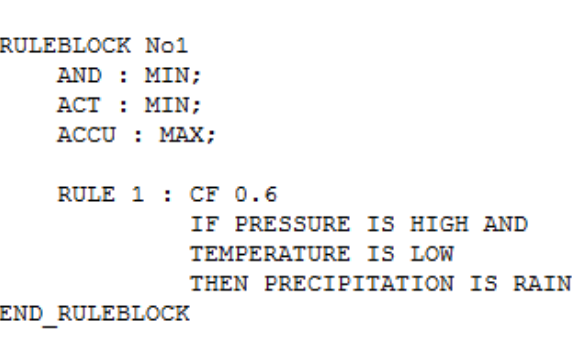
Figure 7. An example of an uncertain fuzzy